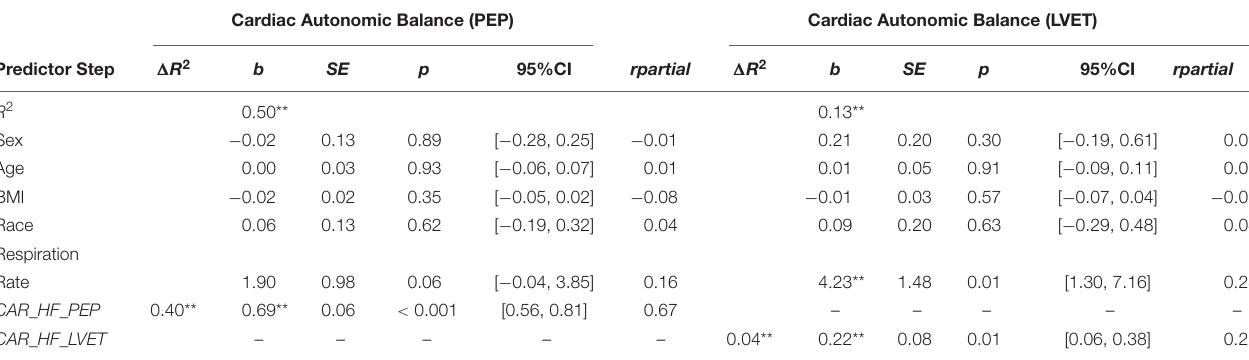
TABLE 4 | Hierarchical regression analyses calculated from HF, PEP, LVET.